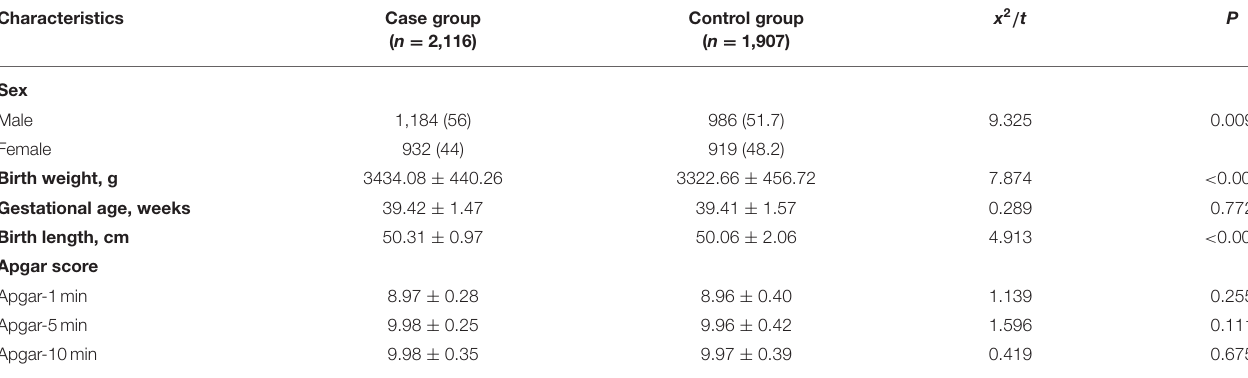
TABLE 2 | Newborn offspring characteristics of participants according to late pregnancy blood glucose among the total participants. Characteristics